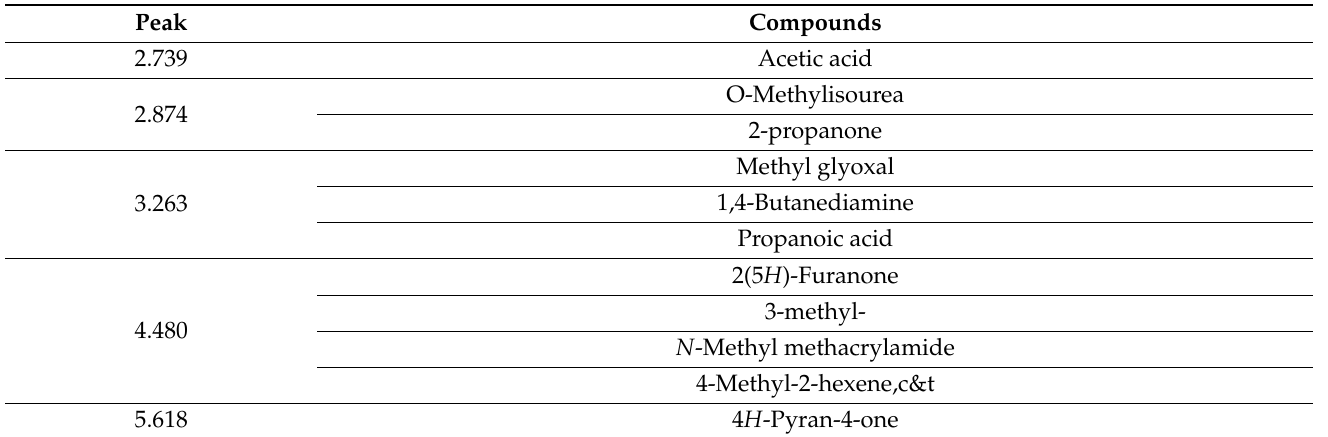
Table 7. Compounds identified in the